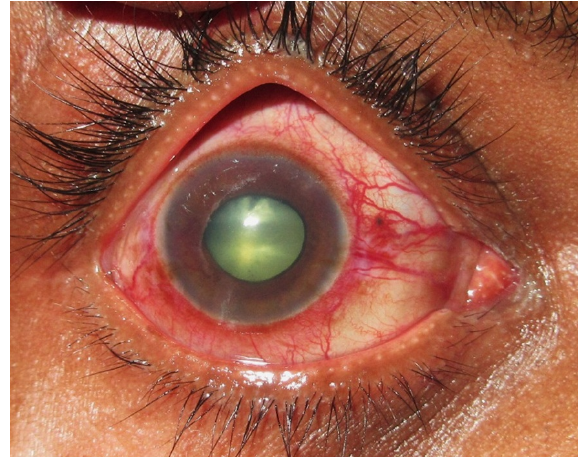
Figure 1: Anterior segment photo of the right eye showing conjunctival congestion, mid-dilated pupil, and iris neovascularization Gonioscopy examination with indentation revealed angle closure without any sign of neovascularization. The left eye showed a visual acuity of 20/20 with –0.75 DS cor- anterior chamber and normal disc and macula. Ultrasono- graphy of the right eye revealed a mushroom-shaped, a base diameter of approximately 15 mm with low to ture suggestive of choroidal melanoma (Figure